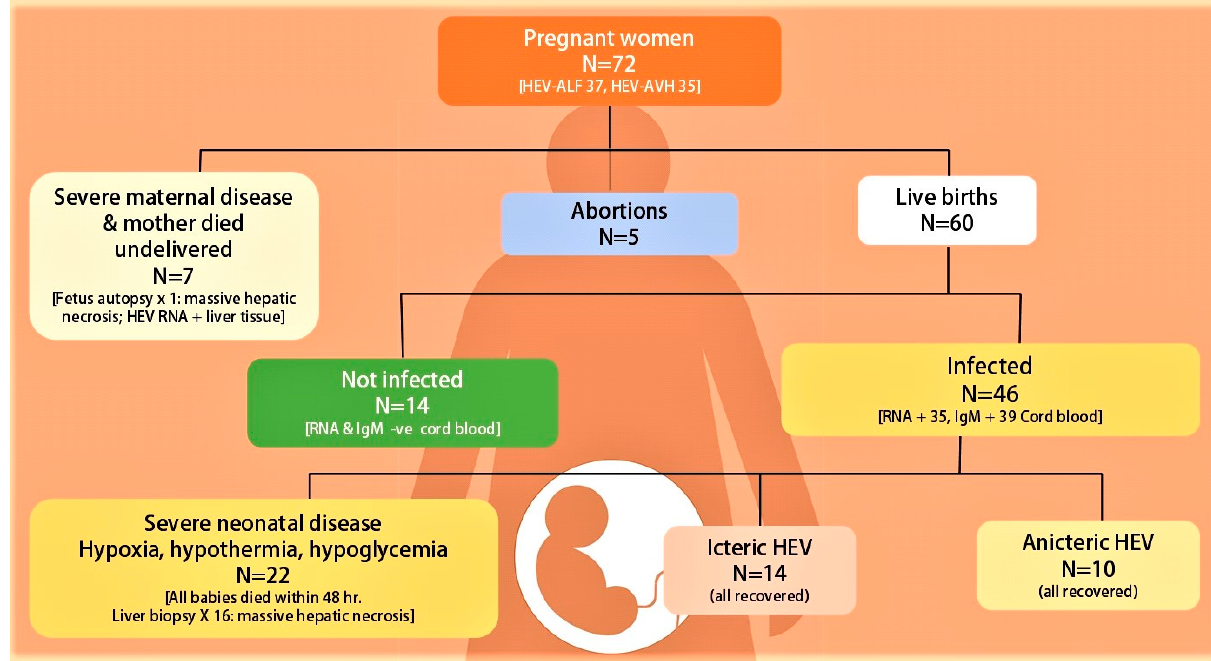
Figure 4. Fetal-neonatal hepatitis E virus infection recorded in fetuses and neonates from 72 pregnant women with hepatitis E virus infection seen at Sher-I-Kashmir Institute of Medical Sciences, Srinagar Kashmir, India from Dec 1993 onwards [140,174,175]. ALF = acute liver failure, RNA = HEV RNA, IgM = IgM anti-HEV.